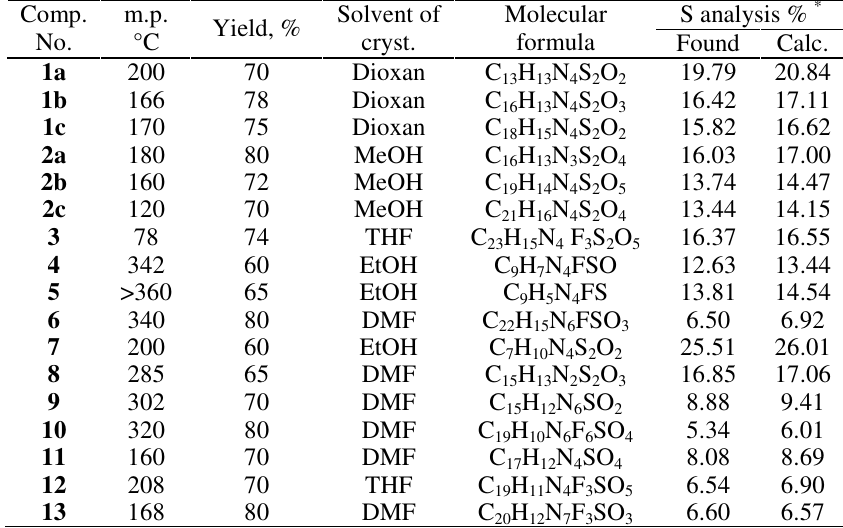
Table 1. Physical properties of new fluorine heterocyclic systems ( 1-13 )